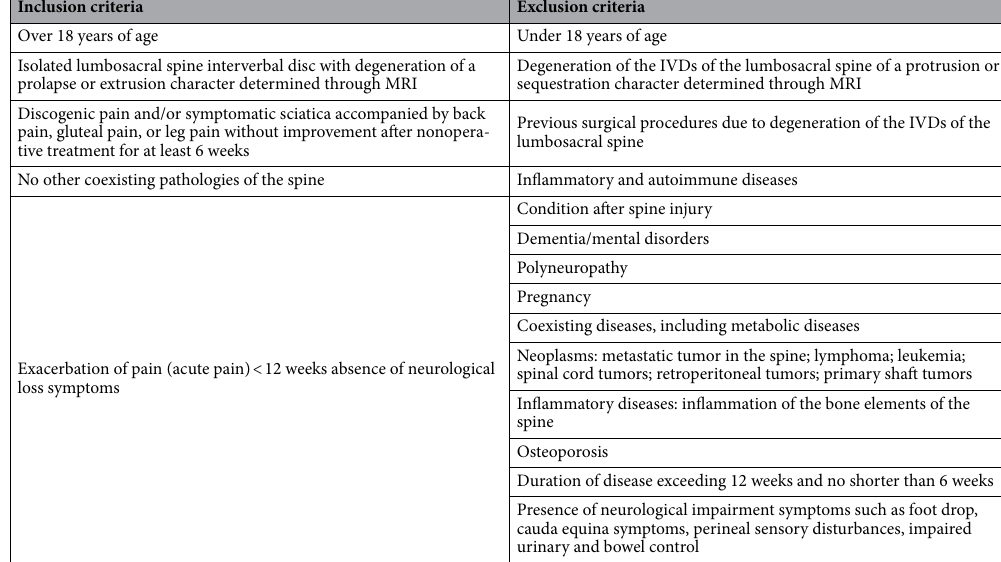
Table 5. Inclusion and exclusion criteria.